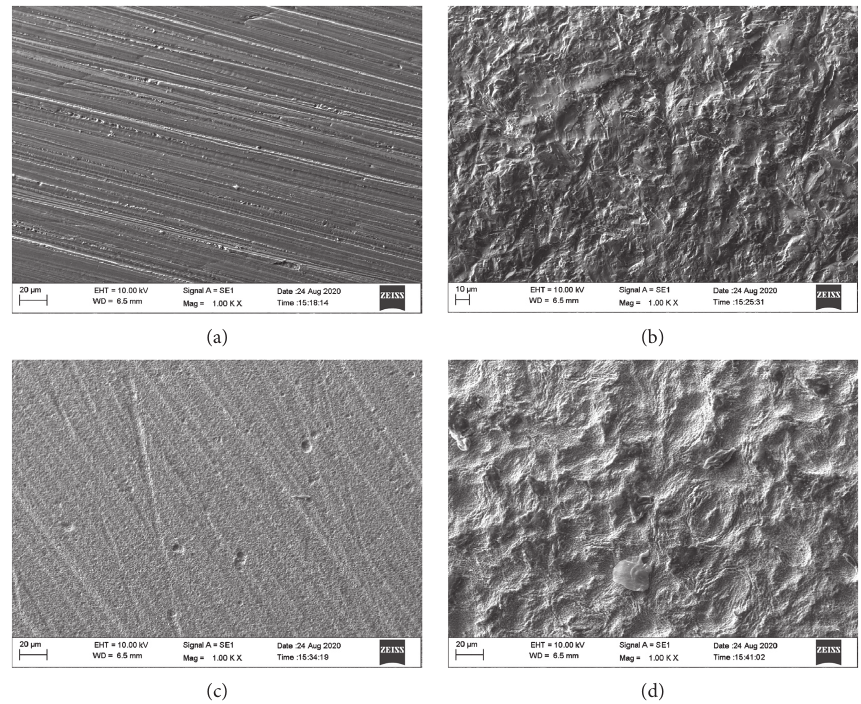
Figure 5: SEM images obtained from each experimental group (Original magnification 1000x). (a) Group TC, (b) Group TA, (c) Group TE, and (d) Group